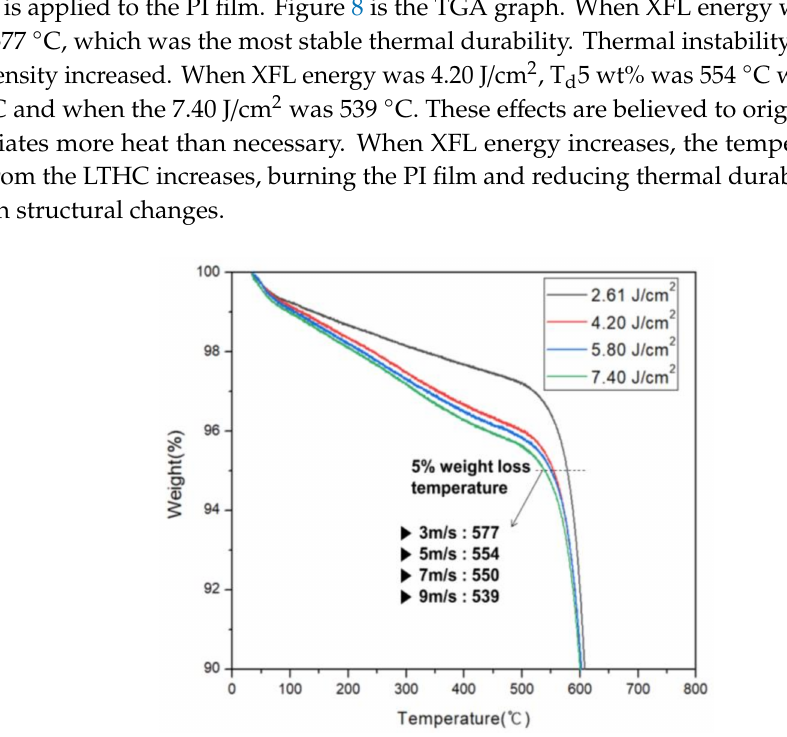
Figure 8. Variation of the obtained TGA with the XFL